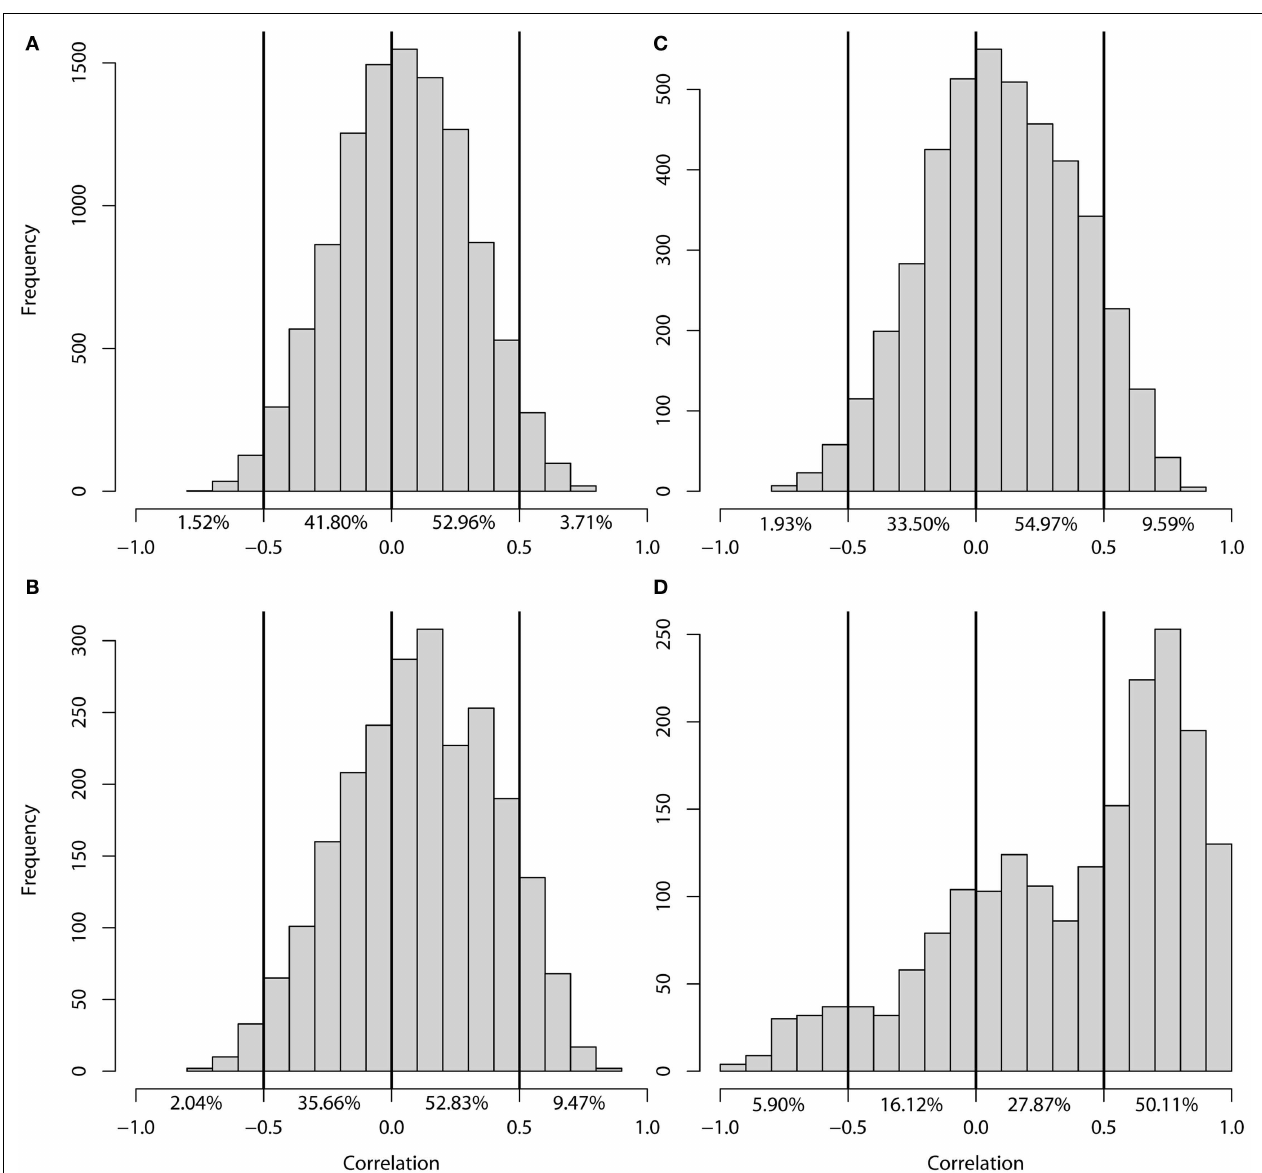
FIGURE 3 | Histogram of the correlation of − log(P) profiles per gene. Correlation between the − log(P) profiles of genes (A) without eQTLs in either experiment, (B) with an eQTL in GG1 only, (C) with an eQTL in GG2 only, (D) with an eQTL in both experiments.